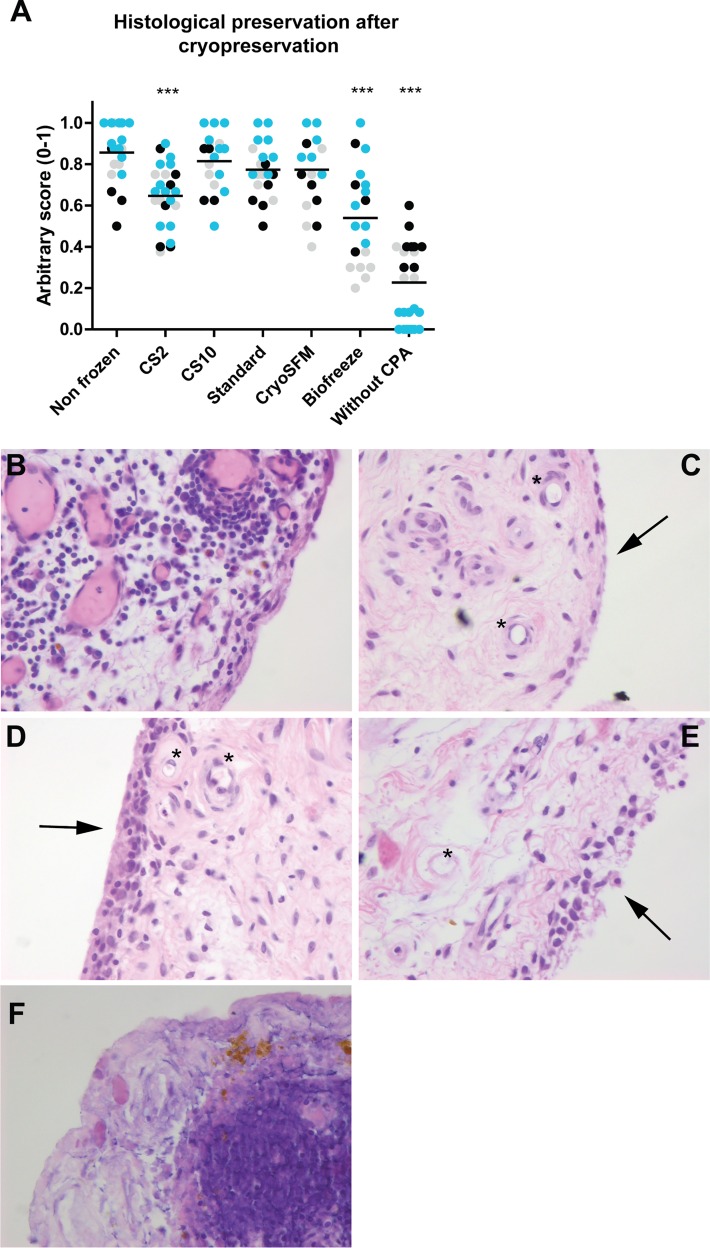
Histological analysis of cryopreserved synovial explants.(A) Histological preservation was determined by assessing global histological parameters using an arbitrary score. Mean score is displayed. A significantly lower score was determined for the CS2, Biofreeze and without CPA condition. Blue dots: patient 1, black dots: patient 2, grey dots: patient 3. For statistical analysis, one-way ANOVA was performed, comparing the non frozen control to the cryopreserved conditions. *** p<0.001. Displayed is the mean. (B) Non frozen highly cellular synovium from patient 1. (C) Synovium of low cellularity cryopreserved with CryoSFM of patient 2 displaying an intact and smooth intimal lining layer (arrow), intact cells and blood vessels (*). (D) Synovium from patient 3 cryopreserved with CryoSFM, displaying mainly intimal lining hyperplasia (arrow), the lining is smooth and intact, cells and blood vessels (*) are intact. (E) Synovium of patient 2 cryopreserved using the Biofreeze medium, showing a disrupted intimal lining layer (arrow), a high number of disrupted cells and disrupted blood vessels (*). (F) Synovium of patient 1 frozen without protecting CPA solution showing almost complete disruption of cells.